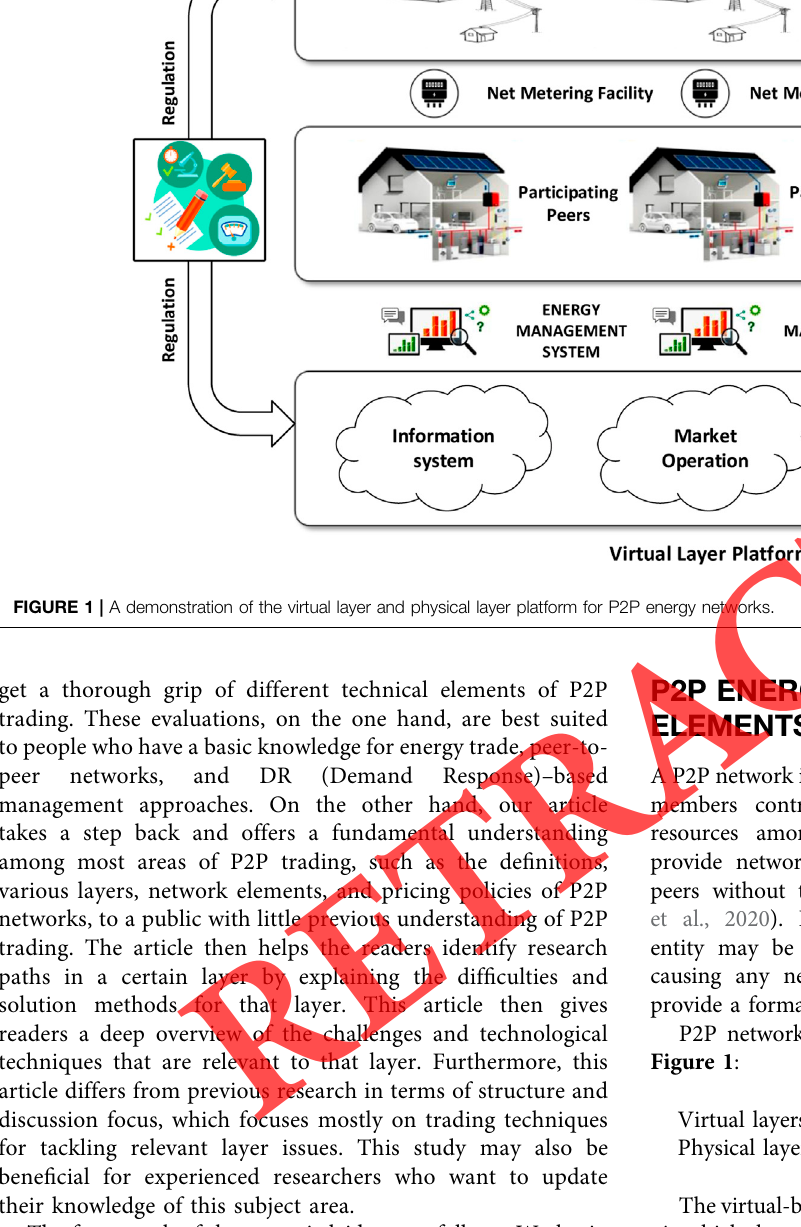
Figure 1 : Virtual layers. Physical layers.